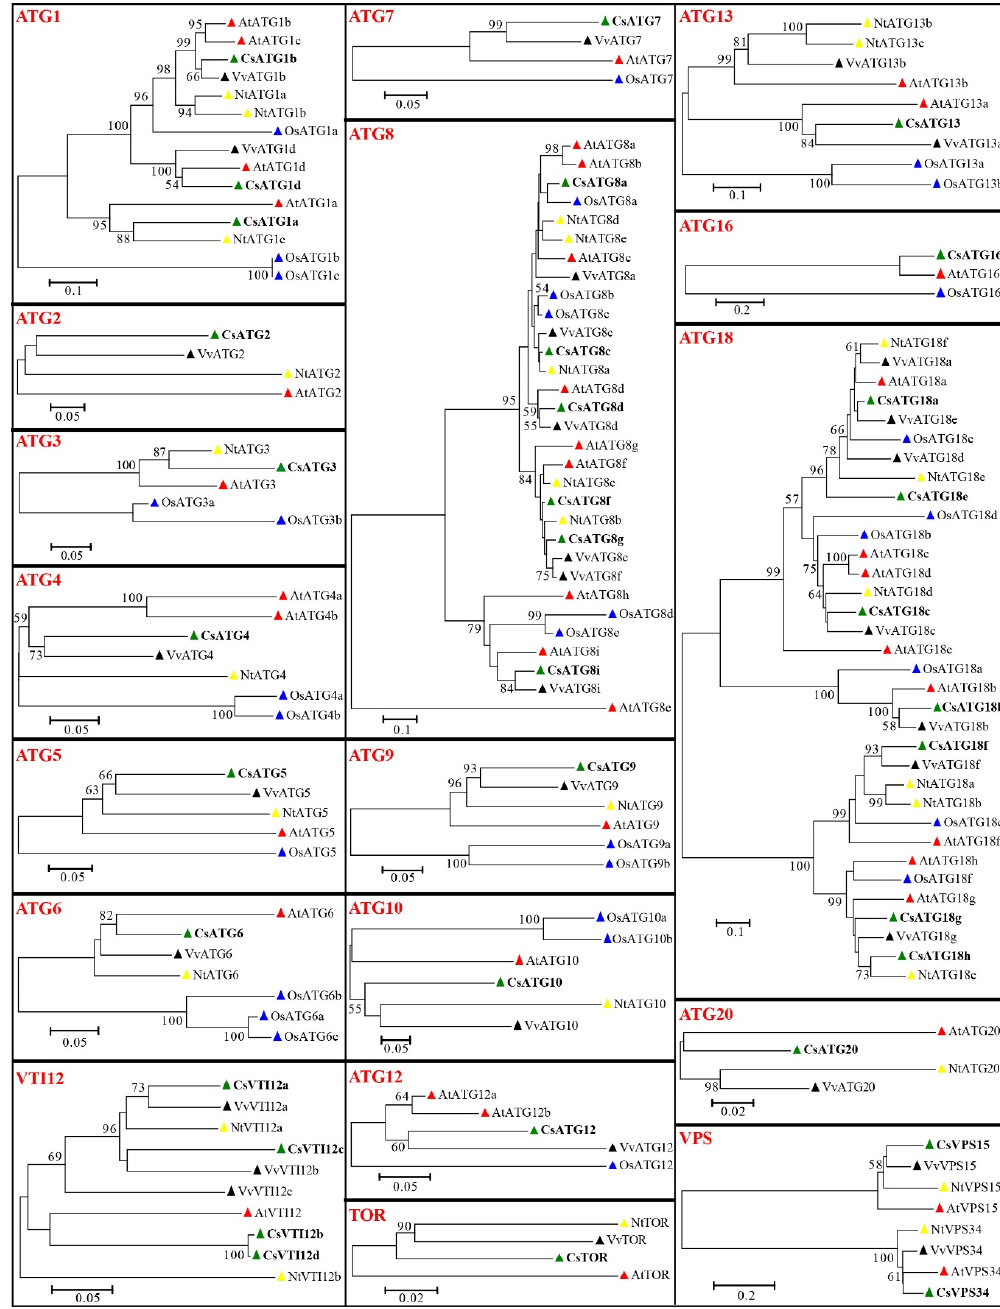
Figure 1. Phylogenetic analysis of sweet orange and other plant ATG proteins. Thirty-five CsATGs of sweet orange ( Citrus sinensis , Cs), 40 AtATGs of Arabidopsis thaliana (At), 30 NtATGs of tobacco ( Nicotiana tabacum , Nt), 31 OsATGs of rice ( Oryza sativa , Os), and 33 VvATGs of grapevine ( Vitis vinifera , Vv) were used to construct the neighbor-joining tree in MEGA 6.0 software, with 1000 bootstrap replicates. The same plant of ATGs are marked with the same color of triangles. The bootstrap values (the number at each node) higher than 50% are shown in the phylogenetic trees.